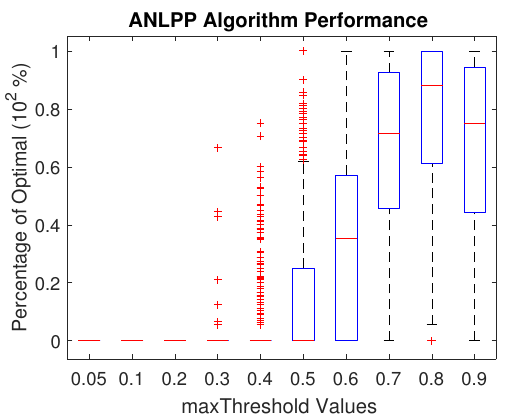
Figure 9. The performance of ANLPP when d = 7 and a different values of maxThreshold used for each run.